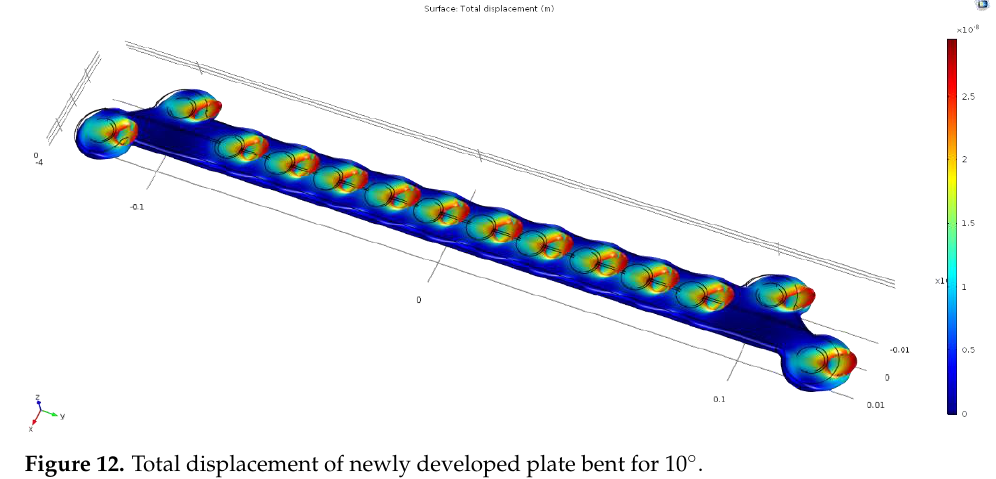
Figure 12. Total displacement of newly developed plate bent for 10 ◦ .